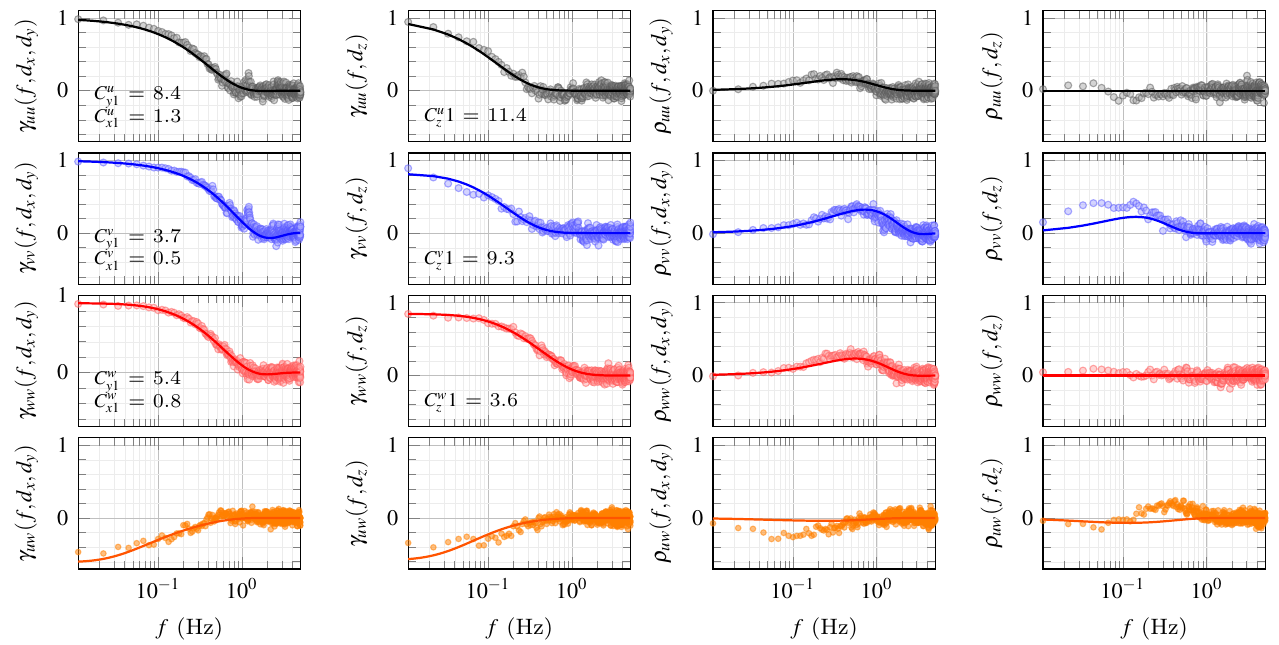
Figure 5. Co-coherence and quad-coherence of the three velocity components estimated for a wind direction of 293°, u = 24 m s − 1 at z = 49 m above ground and a yaw angle of 31° ( d x = 4.1 m, d y = 6.9 m, and d z = 16 m). The data were recorded on 8 December 2017 from 02:00 to 05:00. The solid lines correspond to the best fit of Equation (32) for the co-coherence and Equation (33) for the